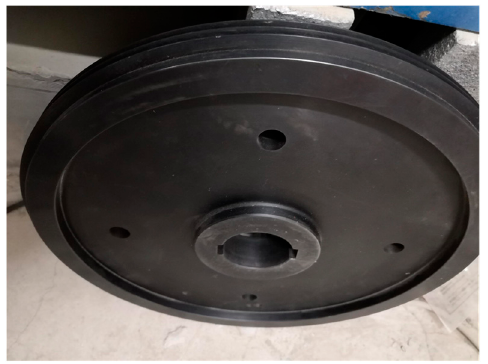
Figure 5. The rotating disk with labyrinth seals and 4 uniformly distributed orifices.